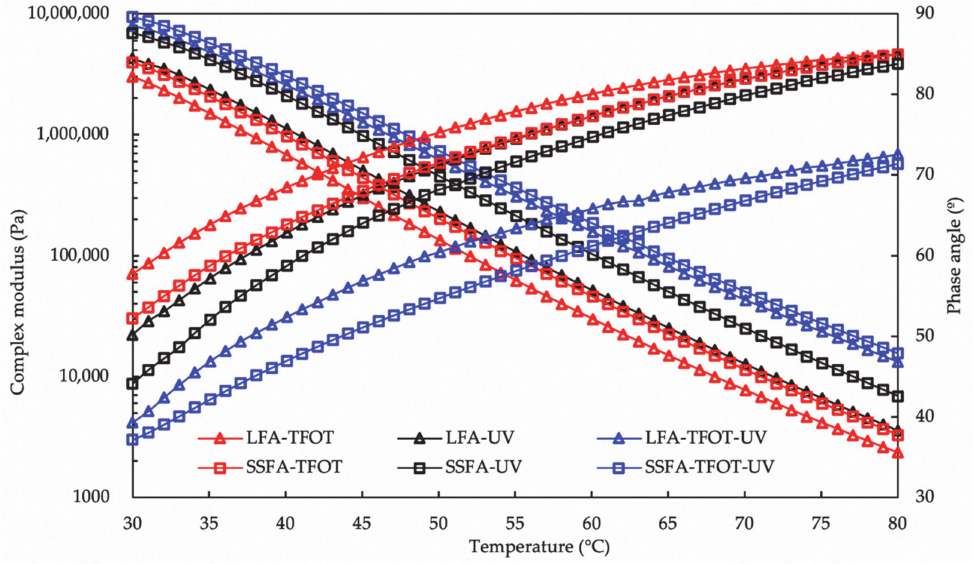
Figure 9. Temperature sweep analysis of SSFA and LFA after TFOT/UV/TFOT+UV aging. The changes of rheological properties of SSFA and LFA before and after